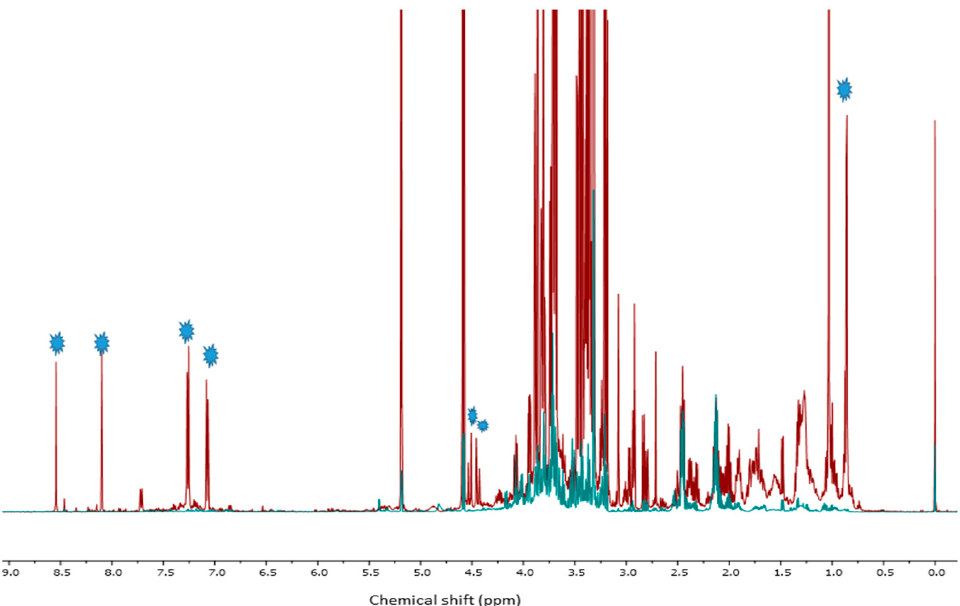
Figure 4. 1 HNMR spectra C. roseus seedlings treated with 0.03% Pronto Plus (red spectra) and 0.001% Pronto Plus (blue spectra); the blue stars indicate the fungicide residue in the samples.